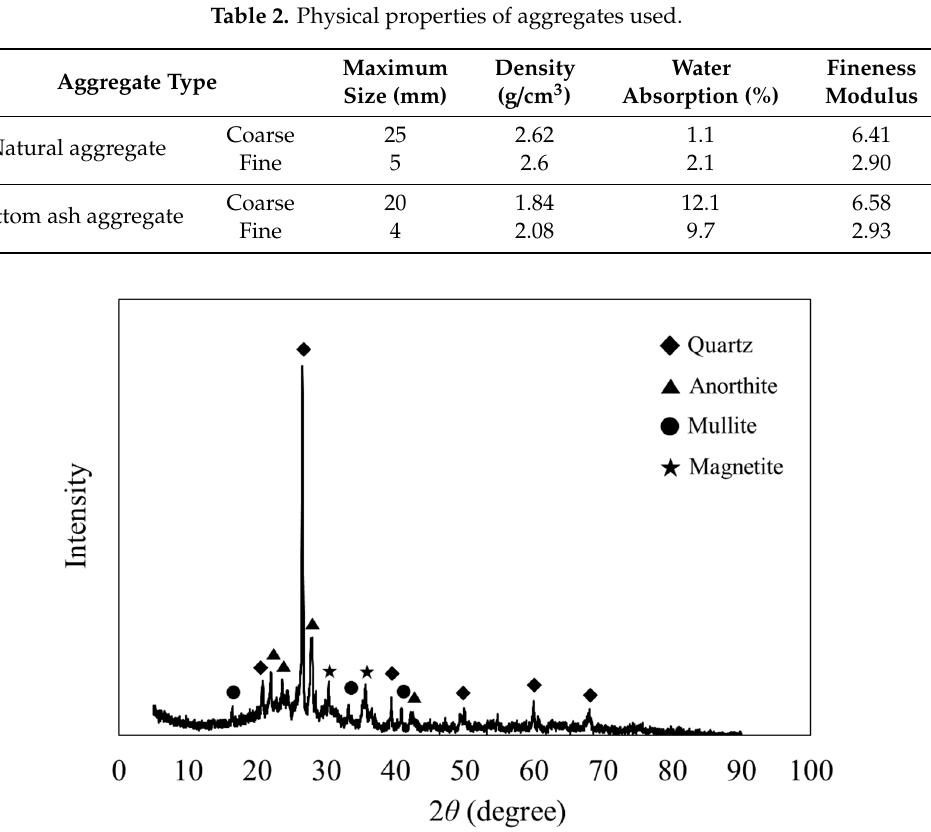
Figure 1. X-ray diffraction patterns of the bottom ash aggregates used. Figure 1. X-ray di ff raction patterns of the bottom ash aggregates